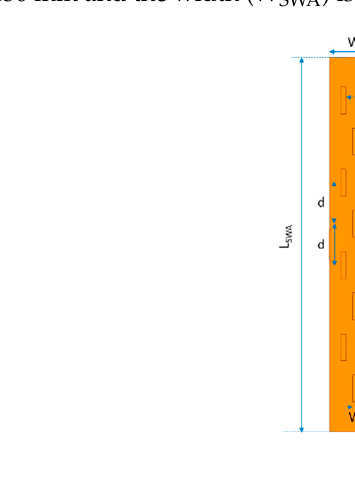
Figure 6. Sixteen-slot waveguide excited by the TE20 mode; ( a ) 3D view and ( b ) upper view. To confirm that the notch at 14.89 GHz present in the parameter |S 21 | of the back-to- back mode converter has no effect on the designed antenna, the realized gains simulated at 14.89 GHz and 15 GHz are presented in Figure 7. Only small differences can be observed in both plane E and H and no reduction of the maximum gain.